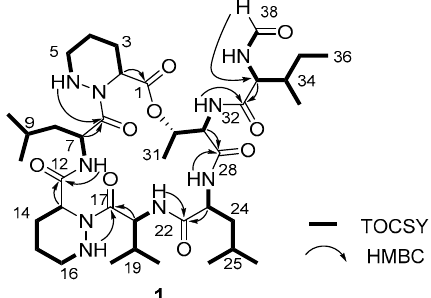
Figure 2. The 1 H- 1 H TOCSY (bold line) and key HMBC (arrow) correlations of depsidomycin B ( 1 ). The molecular formula (C 38 H 65 N 9 O 9 ) of depsidomycin B indicated 11 double bond equivalents.